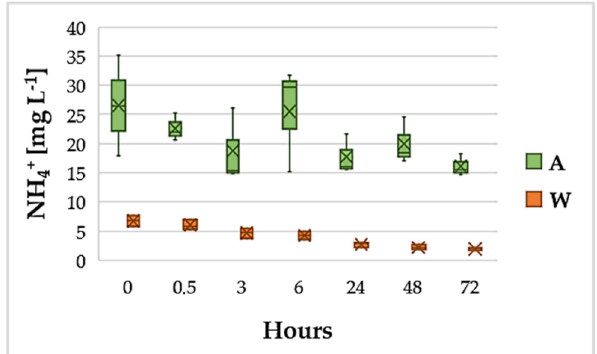
Figure 3. Variation of NH4 + in the wastewater (W) and in the standard growth medium